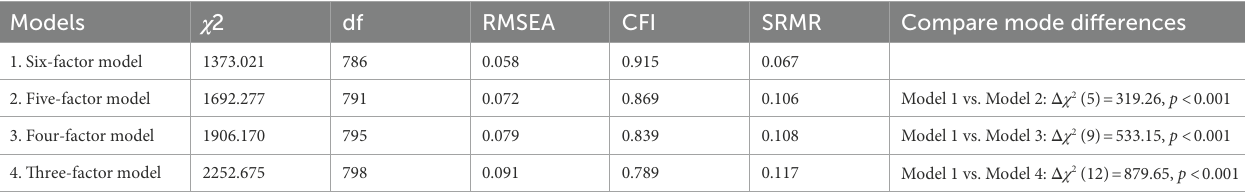
TABLE 2 Results of confirmatory factor analyses (measurement model).